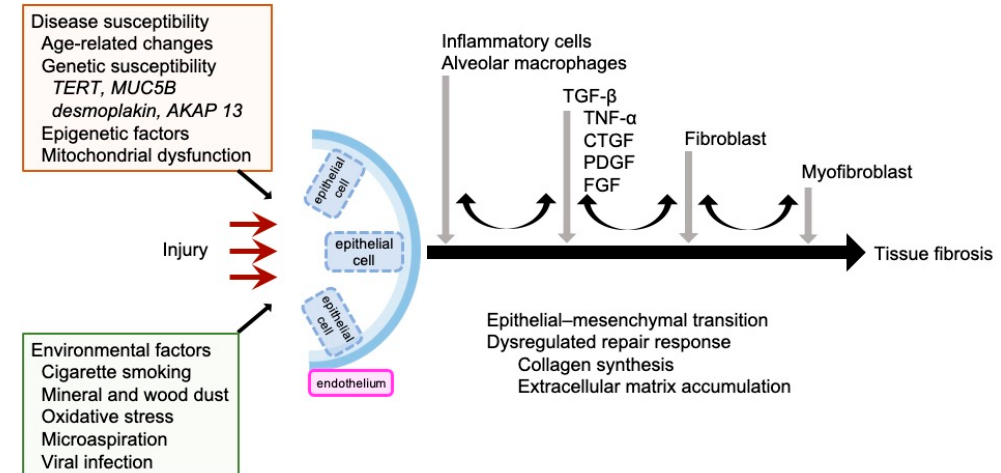
Figure 2. Current concepts of IPF pathogenesis. AKAP 13 , A-kinase anchoring protein 13; CTGF, connective tissue growth factor; FGF, fibroblast growth factor; MUC5B , mucin 5B; PDGF, platelet-derived growth factor; TERT , telomerase reverse transcriptase; TNF- α , tumor necrosis factor- α .